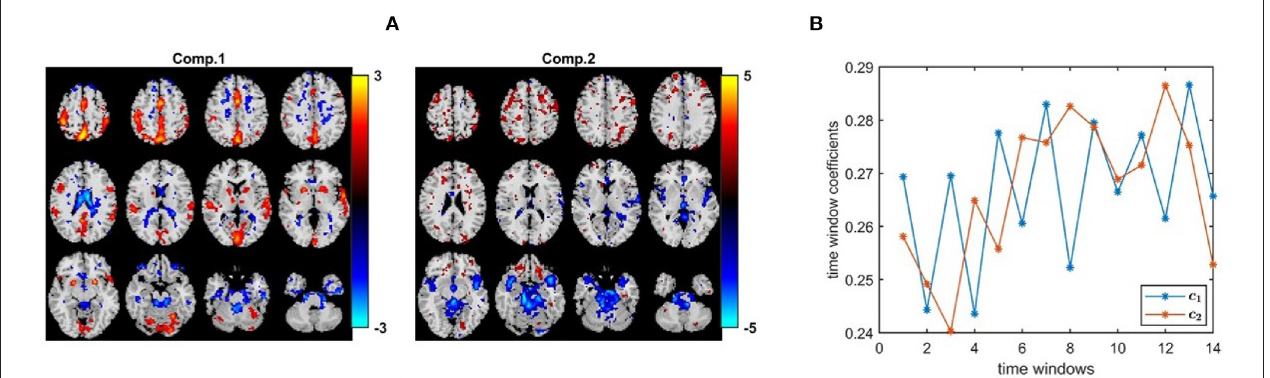
FIGURE 10 | PARAFAC2 analysis of task fMRI data. (A) Spatial components, i.e., columns of B k . Here, we plot columns of only B 1 corresponding to the first time window. The corresponding p -values are 7.8 × 10 − 6 for component 1, and 7.7 × 10 − 1 for component 2. The first component includes primary and secondary motor and cerebellum, as well as auditory cortex expected to be engaged by the task. Spatial maps are plotted using the patterns from the voxels mode as z-maps and thresholding at | z | ≥ 1.5 such that red voxels indicate an increase in controls over patients, and blue voxels indicate an increase in patients over controls. (B) Temporal patterns, i.e., columns of matrix C .